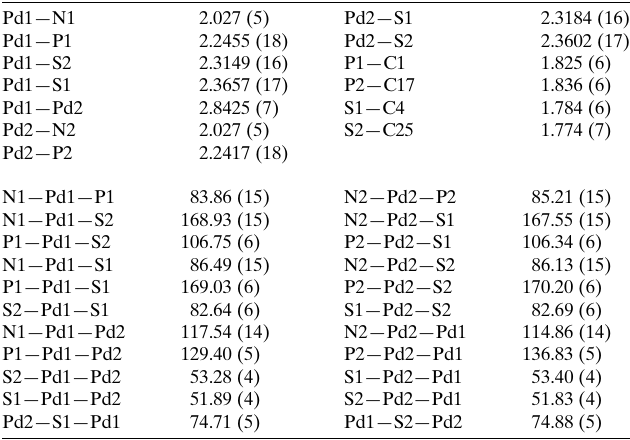
Table 1 Selected geometric parameters (A˚ , (cid:3) ).